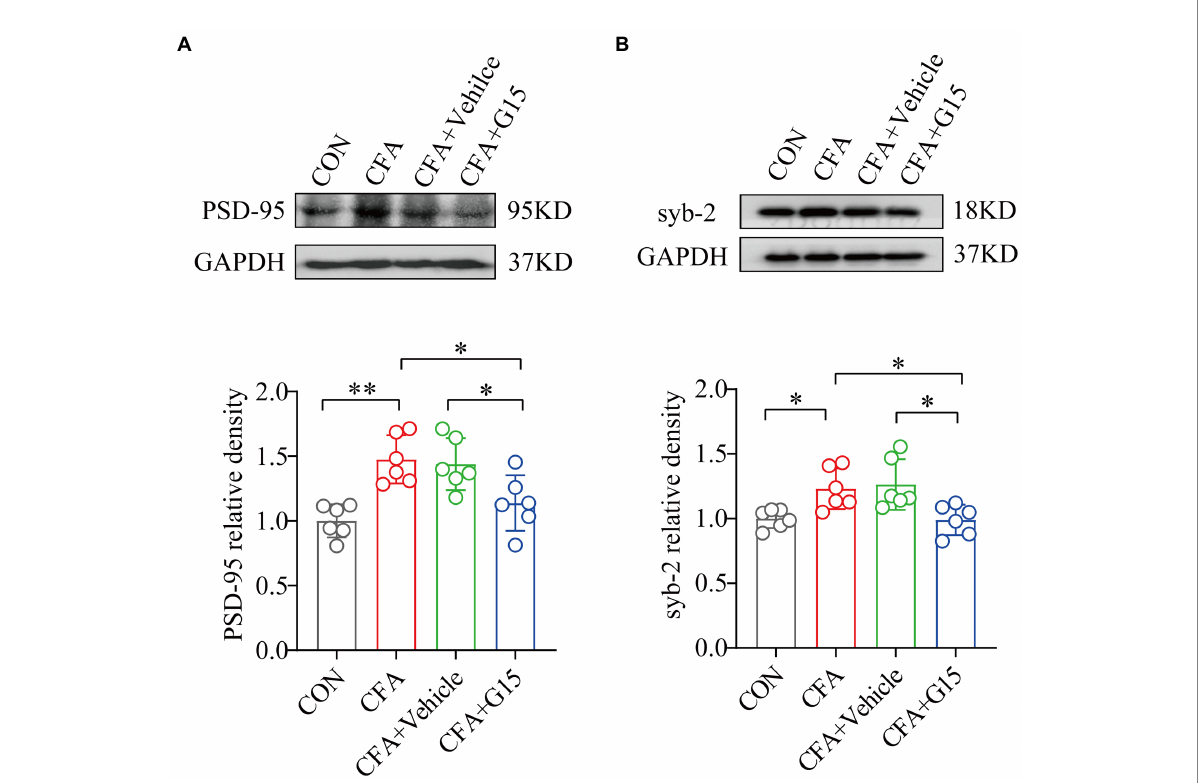
FIGURE 6 Effect of G15 on synapse-associated protein expression levels. Representative WB bands showing the expression of PSD-95 (A) and syb-2 (B) . WB detection of PSD-95 and syb-2 expression in RVM. PSD-95 (A) and syb-2 (B) protein levels were down-regulated in the CFA + G15 group compared with the CFA group, and there was no significant difference between the CFA group and CFA + Vehicle group. All data were normalized to the GAPDH control group. All statistical analysis was performed using one-way ANOVA followed by the Tukey post hoc test for multiple group comparisons. * p < 0.05, ** p < 0.01. n = 6 per